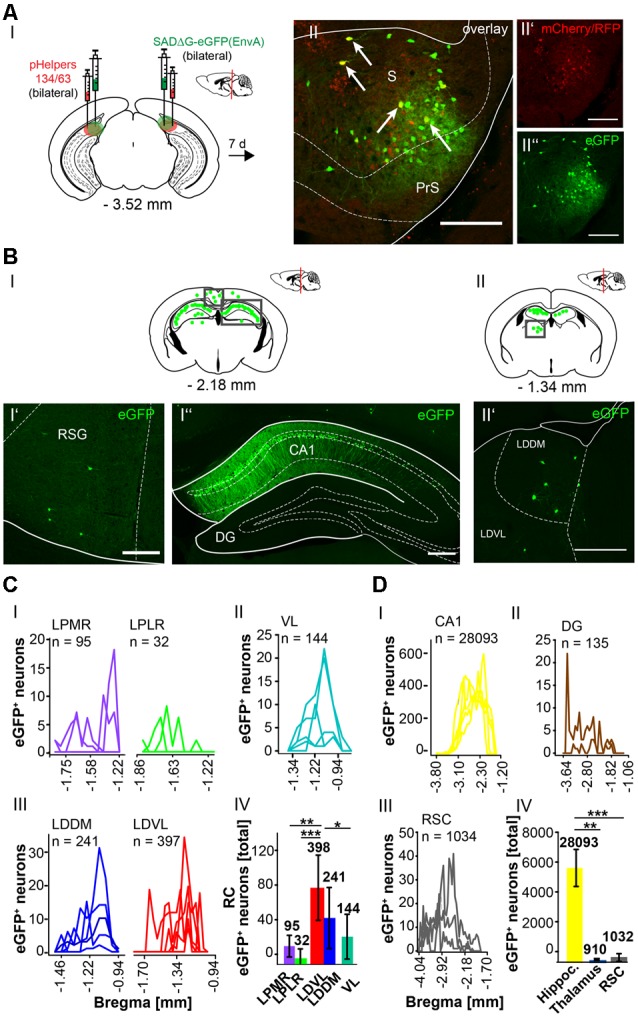
Identifying a monosynaptic circuit to the subiculum from the thalamus using the retrograde, modified RABV tracer. (A) Schematic of a coronal section at Bregma −3.52 mm (AI) from an adult mouse brain injected bilaterally with the retrograde specific, modified RABV tracer (green circle, 0.1 μl, AII”) and pHelper mixture (red circle, AII’) in the subiculum (S) and presubiculum (PrS) of n = 5 mice. The pHelper viruses rAAV8-CBA-RG-mCherry and rAAV8-CBA-mRFP-IRES-TVA (1:2 ratio, 0.2 μl) were injected 7 days prior to the SADΔG-eGFP (EnvA) rabies virus. Animals were sacrificed 7 days after modified RABV injection. (AII) Confocal image showing co-expression of both pHelper and rabies viruses. Scale bars: 250 μm. (BI) Coronal brain scheme at −2.18 mm from Bregma showing eGFP+ neurons (green dots) by monosynaptic retrograde transport from the S and PrS to the (RSG, BI’) and hippocampal CA1 (BI”). (BII) Coronal brain section at Bregma −1.34 mm depicting eGFP+ neurons by monosynaptic retrograde transport from the S and PrS to hippocampal CA1 and laterodorsal and ventrolateral thalamus (LDDM/LDVL, BII’). Scale bar: 250 μm. (CI–III) Line plots mapping the individual distribution of eGFP+ neurons by retrograde monosynaptic transport from the S and PrS to the lateral posterior thalamic nucleus, mediorostral and laterorostral parts (LPMR/LPLR, CI), ventrolateral thalamus (VL, CII) and LDDM and LDVL (CIII). (CIV) With total 398 eGFP+ cells, the LDVL provides strongest synaptic input to the S and PrS compared to LPMR (p ≤ 0.001), LPLR (p = 0.006) and VL (p = 0.024, analyzed with One-Way-ANOVA; DI) Line plots mapping the individual distribution of eGFP+ neurons by retrograde monosynaptic transport from the S and PrS to the CA1 (DI) and DG (DII) region of the hippocampus and to the RSC (DIII). eGFP+ cells in the DG were found in two of the five analyzed mice. (DIV) Compared to the thalamic nuclei (CI–III) and RSC (DIII), the hippocampus exhibited a total of 28,228 eGFP+ cells, which is significantly more than in the thalamus (p = 0.008, Mann-Whitney U) and RSC (p ≤ 0.001, t-test).Significance for comparisons: *p ≤ 0.05; **p ≤ 0.01; ***p ≤ 0.001.DG, dentate gyrus; LDDM, dorsomedial laterodorsal thalamic nucleus; LDVL, ventrolateral laterodorsal thalamic nucleus; LPLR, laterorostral lateral posterior thalamic nucleus; LPMR, mediorostral lateral posterior thalamic nucleus; PrS, Presubiculum; RSC, retrosplenial cortex; RSG, granular retrosplenial cortex; S, Subiculum; VL, ventrolateral thalamus. The mouse brains in this figure has been reproduced from Franklin and Paxinos (2001).